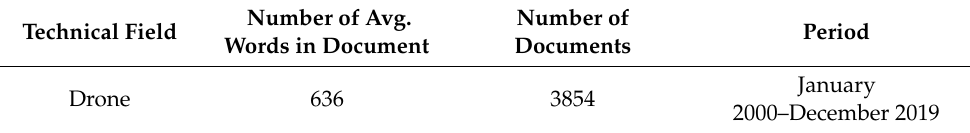
Table 1. Collected data—Patent